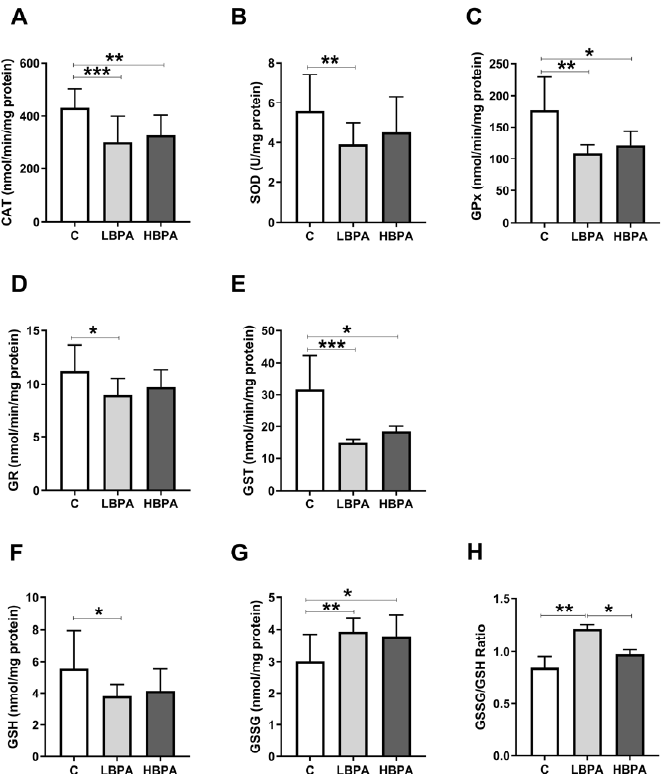
Figure 2. Antioxidant enzyme activities and glutathione concentrations in livers from lactating dams after exposure to low and high doses of BPA. ( A ) Enzymatic activity of catalase (CAT) in nmol/min/mg protein; ( B ) superoxide dismutase (SOD) in U/mg protein; ( C ) glutathione peroxidase (GPx) in nmol/min/mg protein; ( D ) glutathione reductase (GR) in nmol/min/mg protein; ( E ) glu- tathione S-transferase (GST) in nmol/min/mg protein. ( F ) Concentration of reduced glutathione (GSH) in nmol/mg protein; ( G ) concentration of oxidized glutathione (GSSG) in nmol/mg protein. ( H ) GSSG/GSH ratio. Data represent mean ± SD. n = 8 control dams; n = 8 LBPA dams; n = 6 HBPA dams (two replicates for each sample). Statistical significance was determined by one-way ANOVA. * p < 0.05; ** p < 0.01; *** p < 0.001.